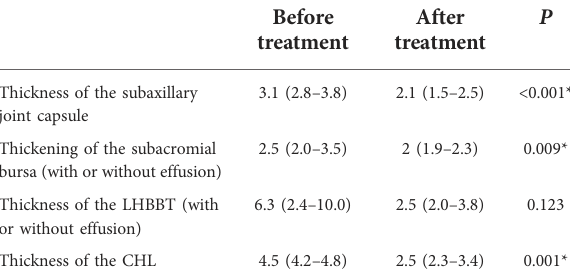
TABLE 2 Comparison of the CMS of the patients before and after P Before After treatment treatment